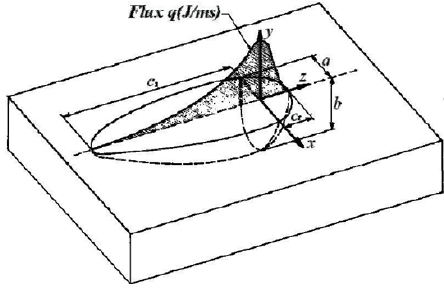
Figure 6. Double ellipsoid heat source model